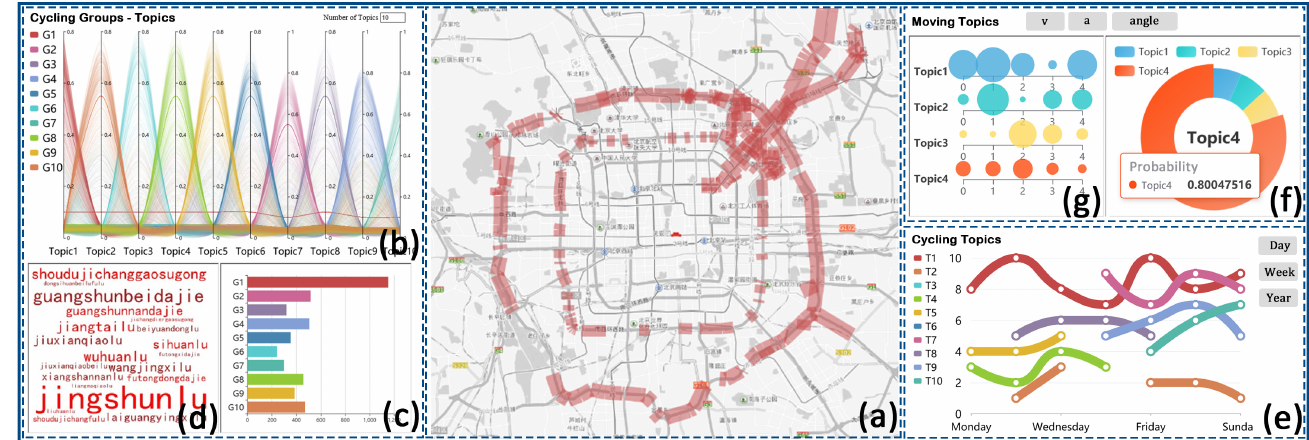
Figure 5. The interfaces of VizCycSemantics system. ( a ) Cycling map. ( b ) Cycling groups and topics. ( c ) Size of cycling groups. ( d ) Street cloud of cycling topics. ( e ) Temporal evolution of cycling topics. ( f ) Moving topic distribution. ( g ) Moving